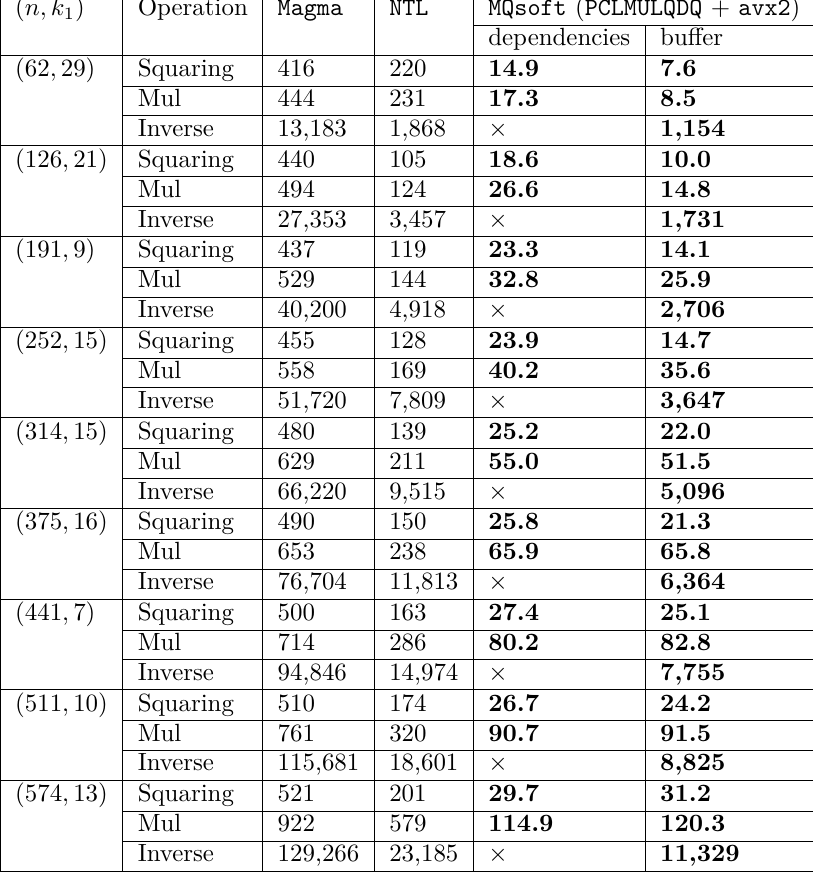
Table 10: Number of cycles by operation in F 2 n . We use a Skylake processor (LaptopS). ( n, k 1